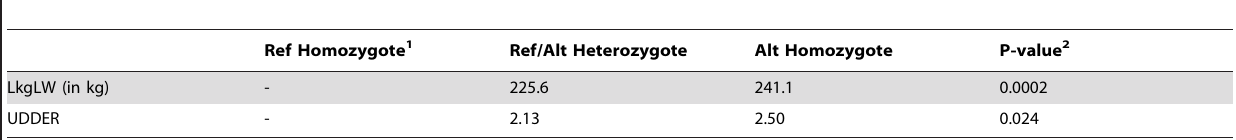
Table 4. Divergent Artiodactyl MYADM- like Repeat genotype contrasts for lifetime kilograms of lamb weaned (LkgLW) and udder condition at fourth year